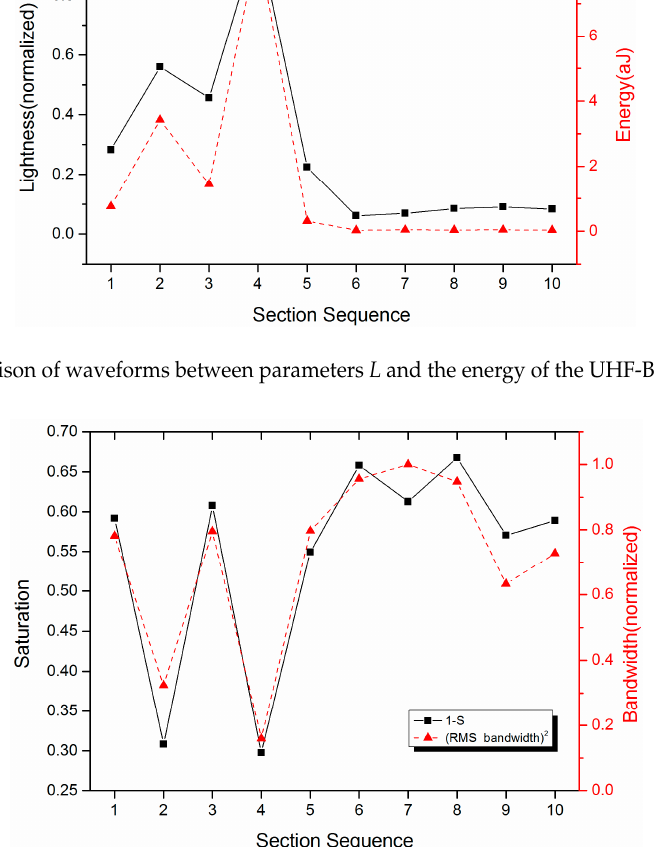
Figure 5. Comparison of waveforms between parameters L and the energy of the UHF-B frequency spectrum.